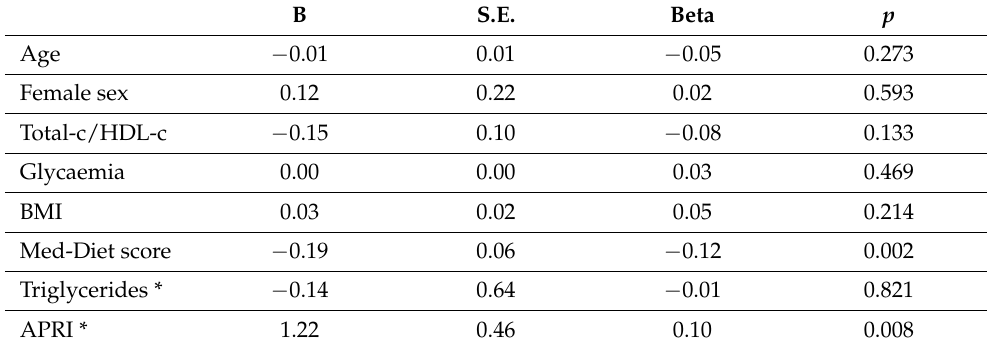
Table 4. Multivariate linear regression analyses of factors associated with Pro-C3. B S.E.